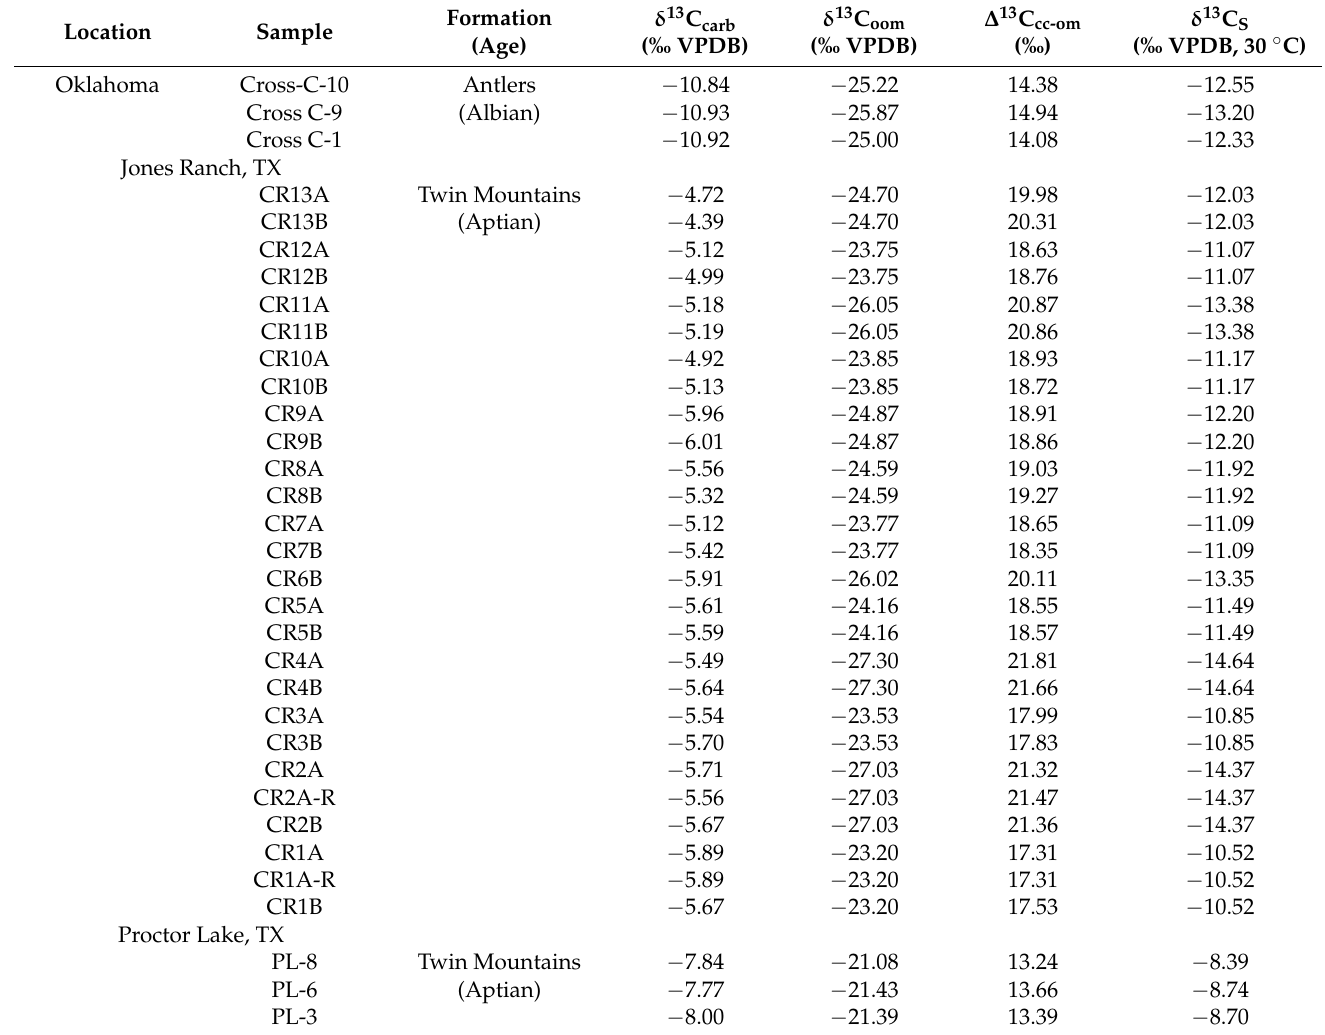
Table 1. The paleosol carbonate stable isotopic values of the measured δ 13 C of calcite ( δ 13 C carb ‰ VPDB), the measured δ 13 C of acid-treated residues containing occluded organic matter ( δ 13 C oom ‰ VPDB), the differences between paired calcite and co-existing occluded organic matter ( ∆ 13 C cc-om ), and the estimated δ 13 C of soil-respired CO 2 at the time of calcite crystallization ( δ 13 C S ) based on the measured values of the occluded organic matter corrected for diffusion enrichment assuming a soil temperature of 30 ◦ C ( δ 13 C S ‰ VPDB, 30 ◦ C). Replicate analyses are marked with